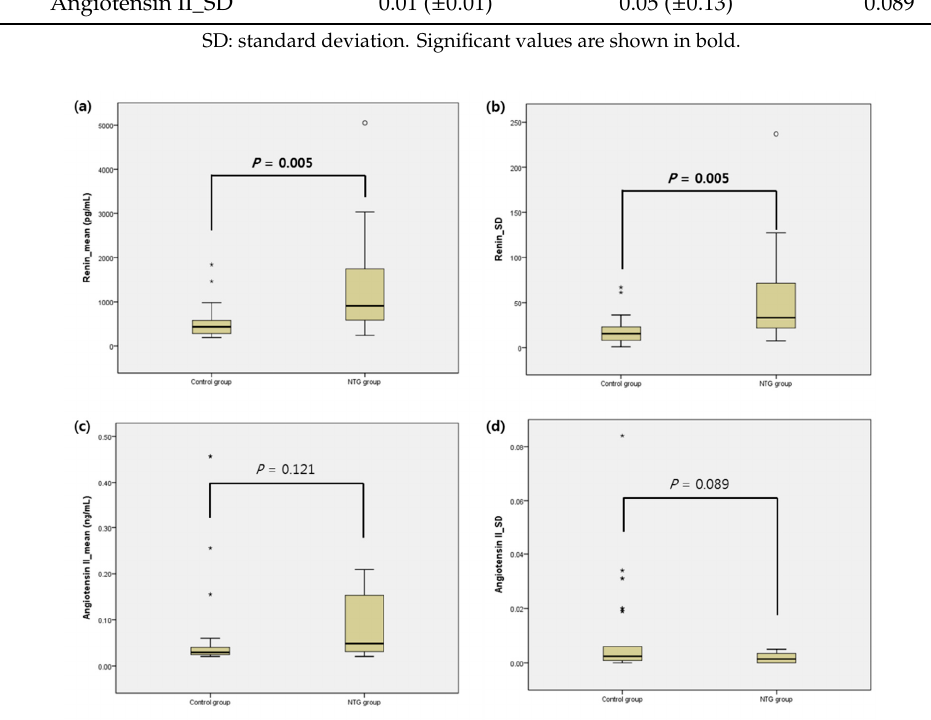
Figure 1. Graphs representing the mean value and standard deviation (SD) of renin and angiotensin II from the plasma of the control and NTG groups. The midline of the box plot represents the mean, while the bar of each box shows the 95% confidential interval. Dots and stars identify the outliers. Outliers of the mean and SD of angiotensin II in the NTG group could not be marked in the graph due to a limitation of scale. In angiotensin II, the mean values of the outliers were 1.84, 3.82, and 10.5.